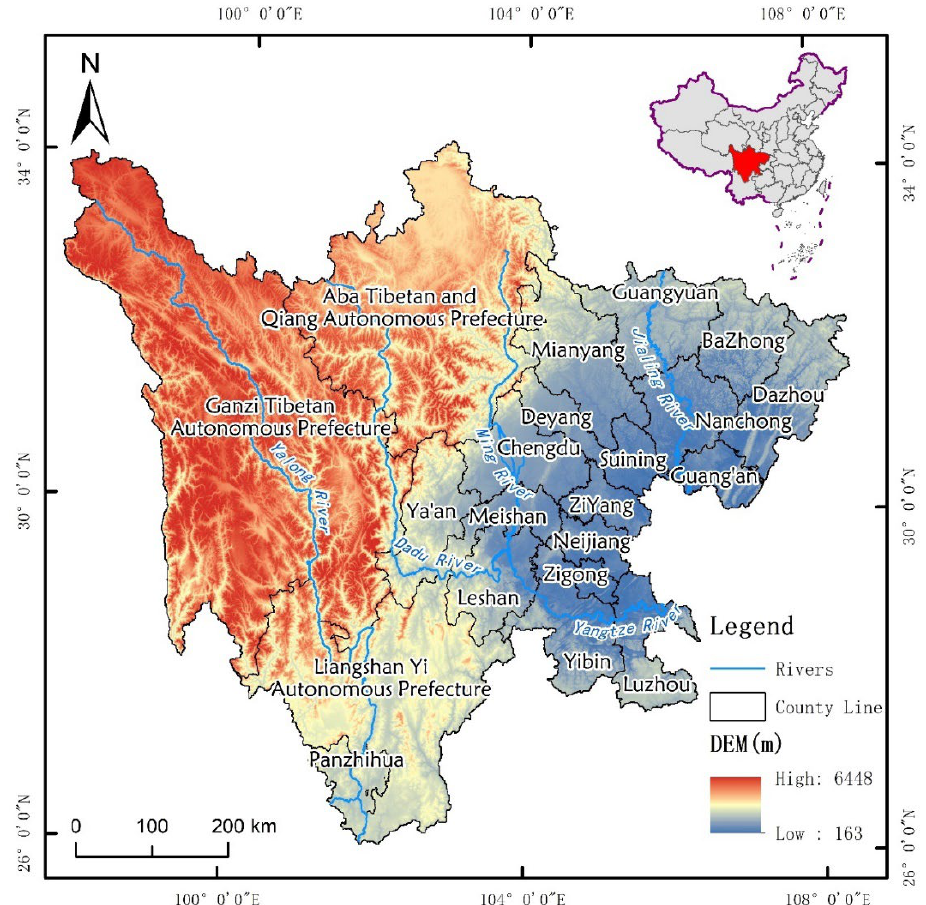
Figure 1. Location of Sichuan Province.